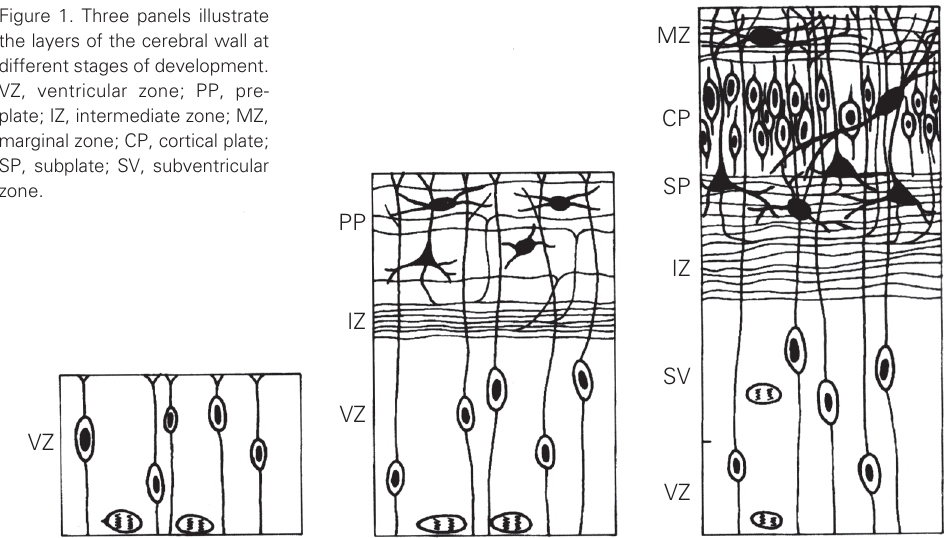
Figure 1. Three panels illustrate the layers of the cerebral wall at different stages of development. VZ, ventricular zone; PP, pre- plate; IZ, intermediate zone; MZ, marginal zone; CP, cortical plate; SP, subplate; SV, subventricular